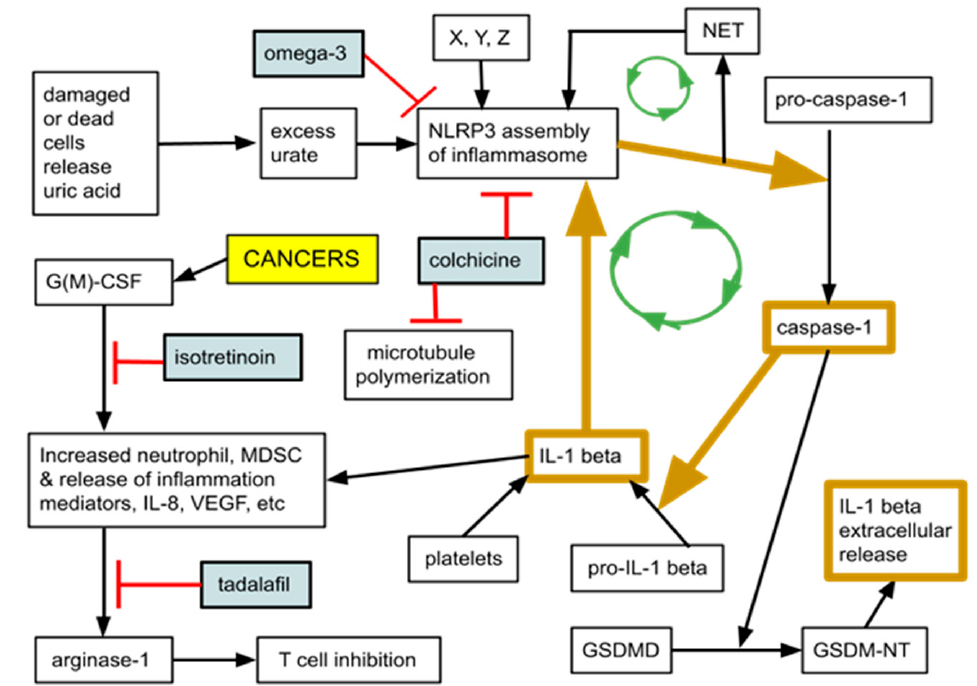
in cancer become pathologically engaged, facilitating tumor growth and metastasis [49,50]. quick reference definitions of these elements.